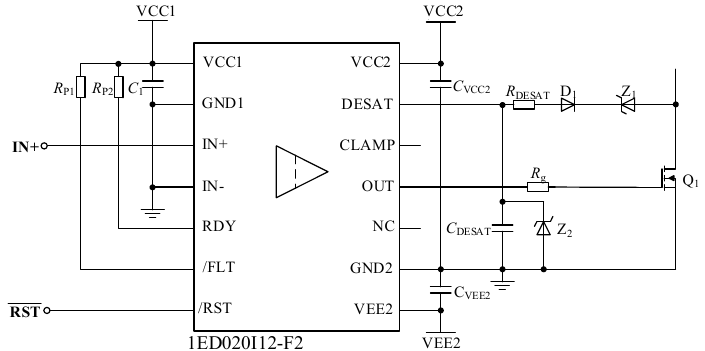
Figure 6. The desaturation detection peripheral circuit based on 1ED020I12-F2.